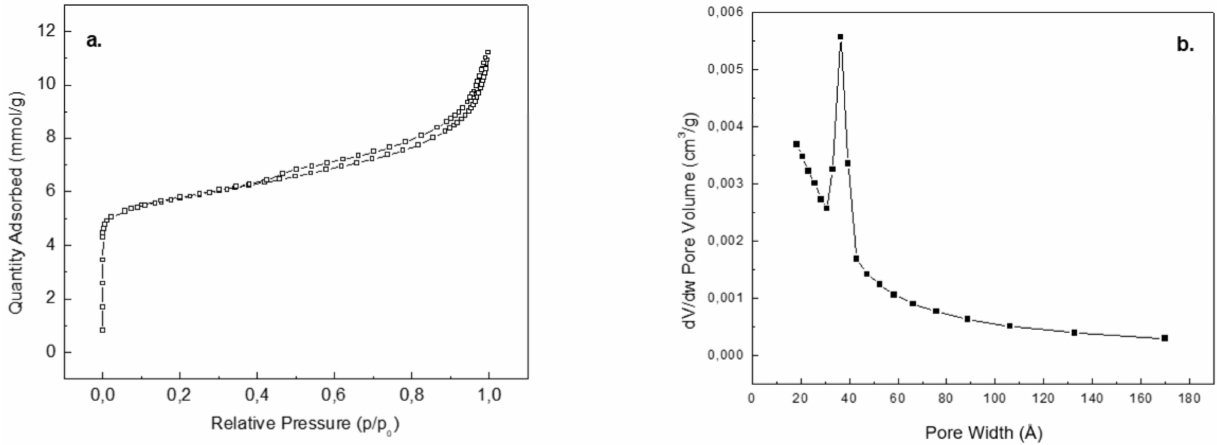
Figure 4. Surface studies of CFAZ: ( a ) N 2 -adsorption/desorption isotherms; ( b ) BJH-pore size distribution